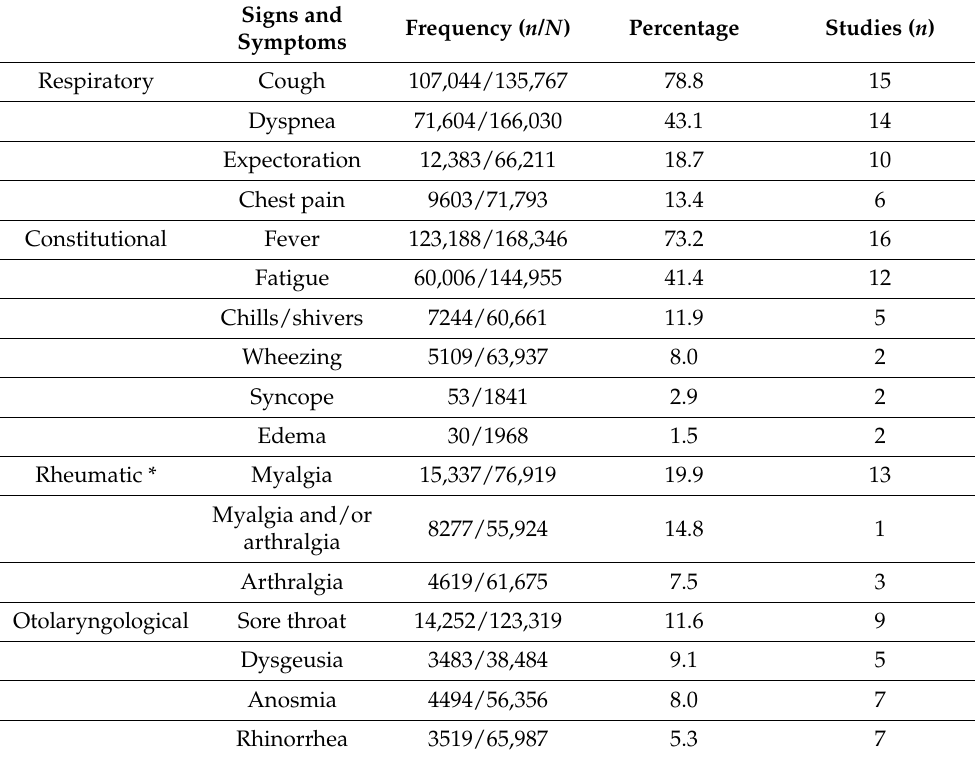
Table 1. Frequency of the main signs and symptoms of acute SARS-CoV-2 infection described in publications with representative cohorts of more than 1000 patients)